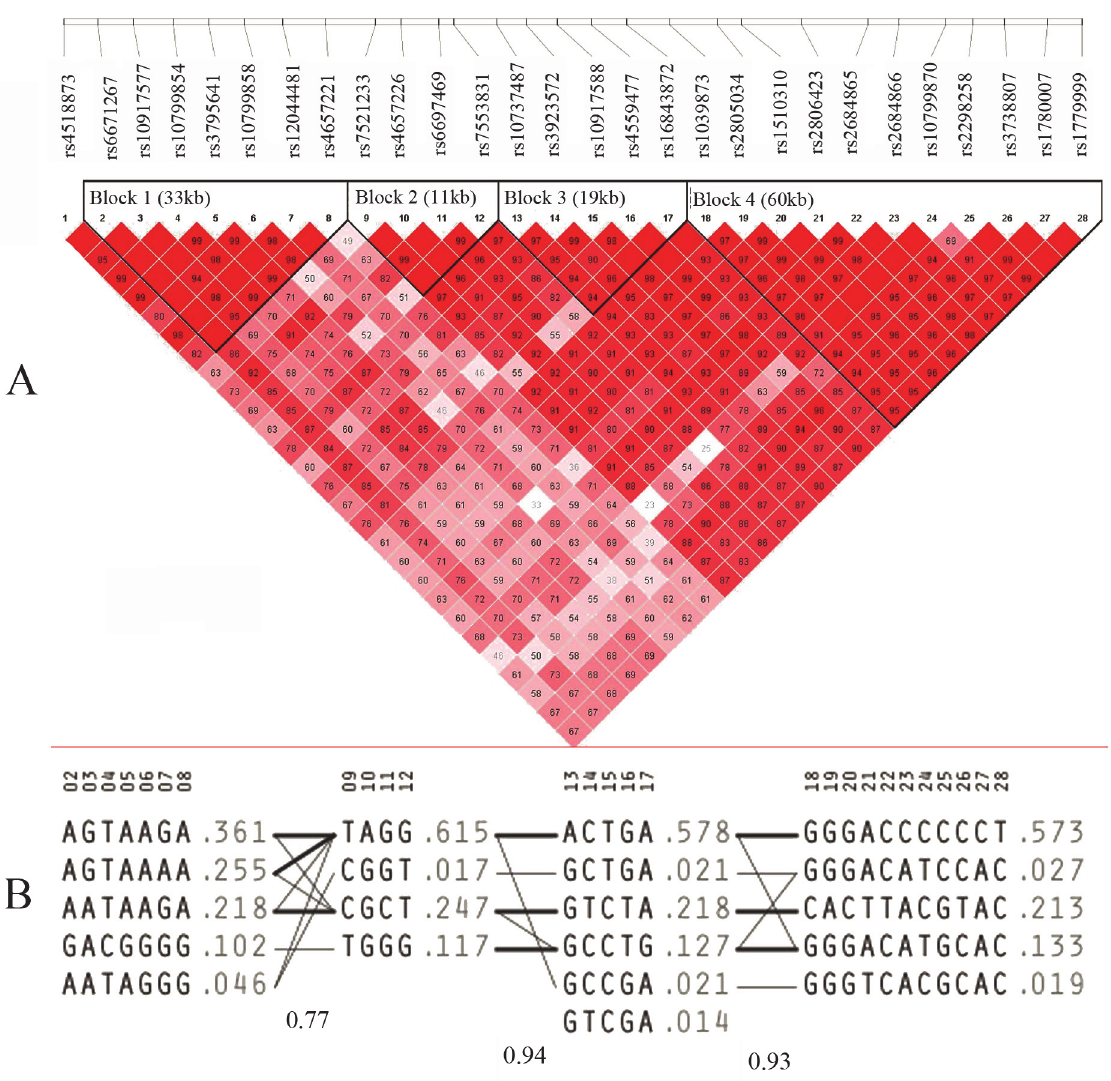
Fig 1. Linkage disequilibrium (LD) blocks and haplotype frequencies for DDR2 in the Chinese BMD sample. (A). LD blocks are marked with triangles. Squares in red indicate strong LD. (B). Haplotypes in the four blocks across DDR2 . The haplotype frequencies are shown to the right of each haplotype. The SNP numbers correspond to those given in Table